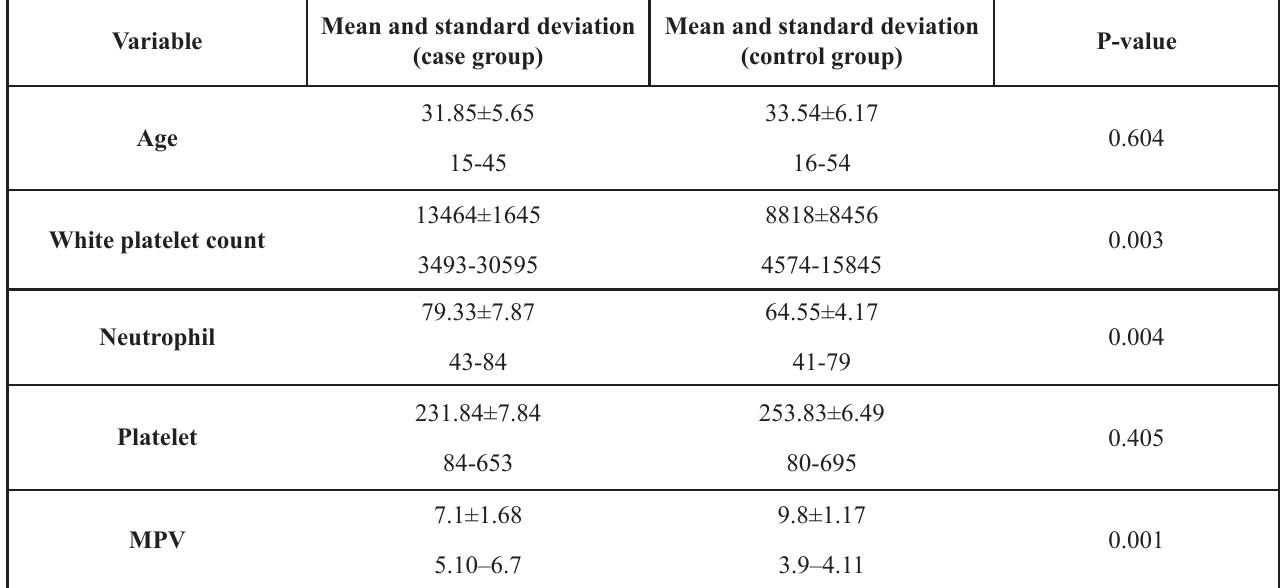
Table 1. Comparison of the mean and standard deviation of the studied variables separately sorted by two groups P-valueMean and standard deviation group)Mean and standard deviation (control (case